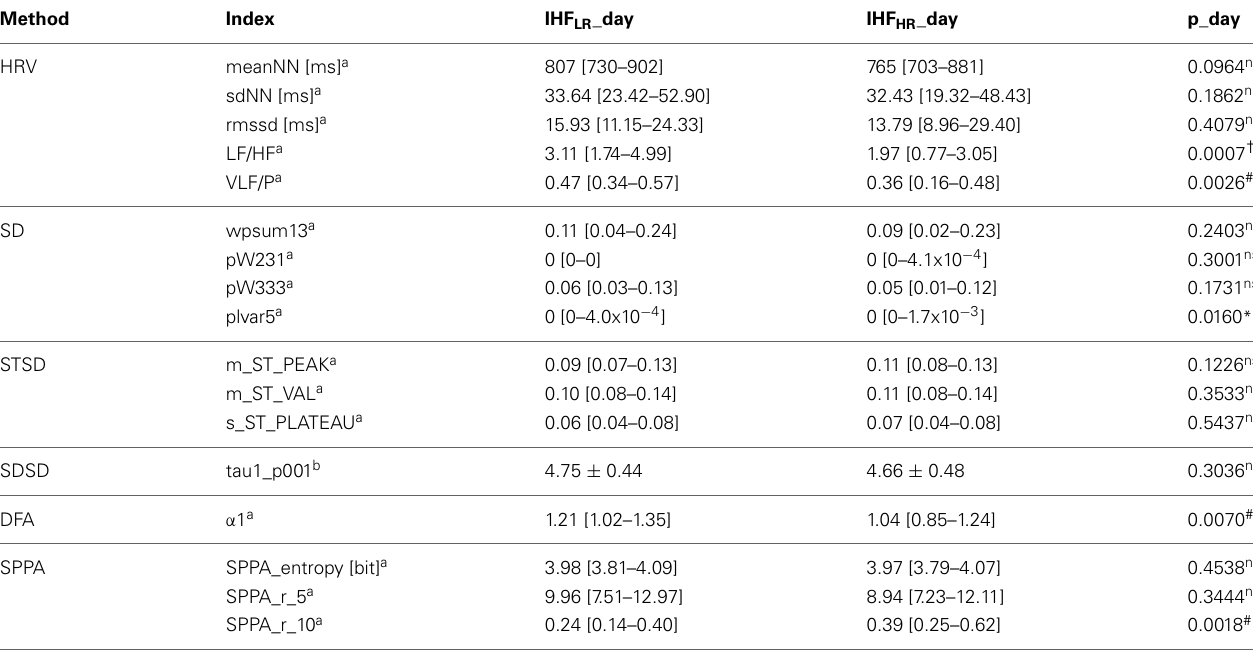
Table 4 | Analysis of 30min most stationary beat-to-beat interval segments of the day phase—univariate statistical analysis results ( U –test) to discriminate between patients with ischemic heart failure at low risk and at high risk (IHF LR and IHF HR ).